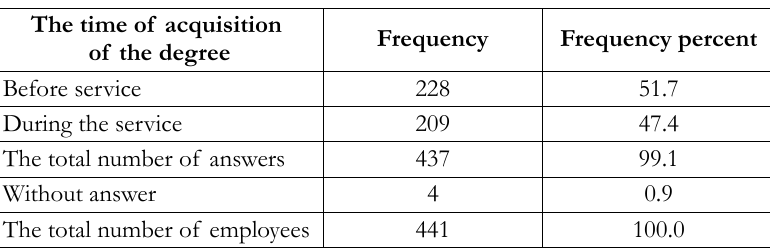
Table 6. The frequency distribution of employees according to the time of acquisition of the degree